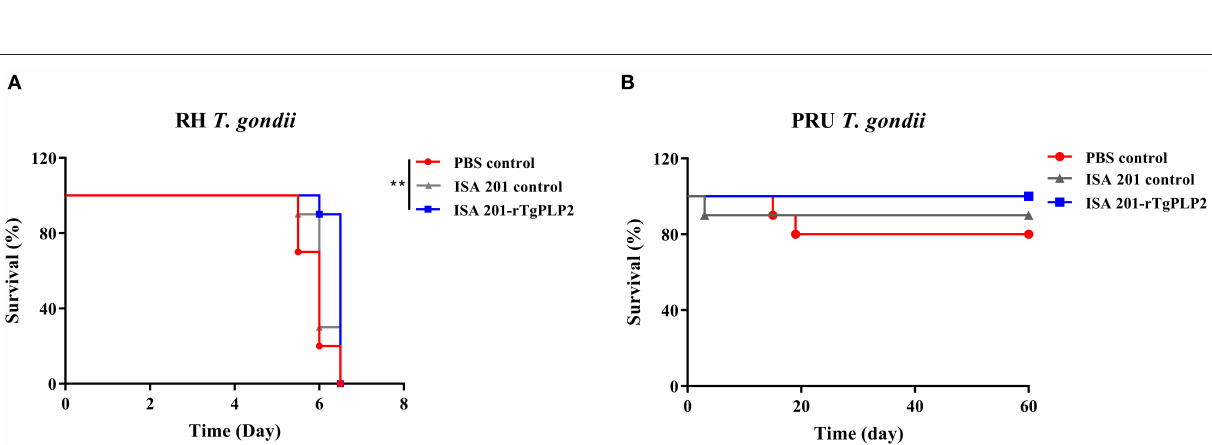
Frontiers in Veterinary Science |